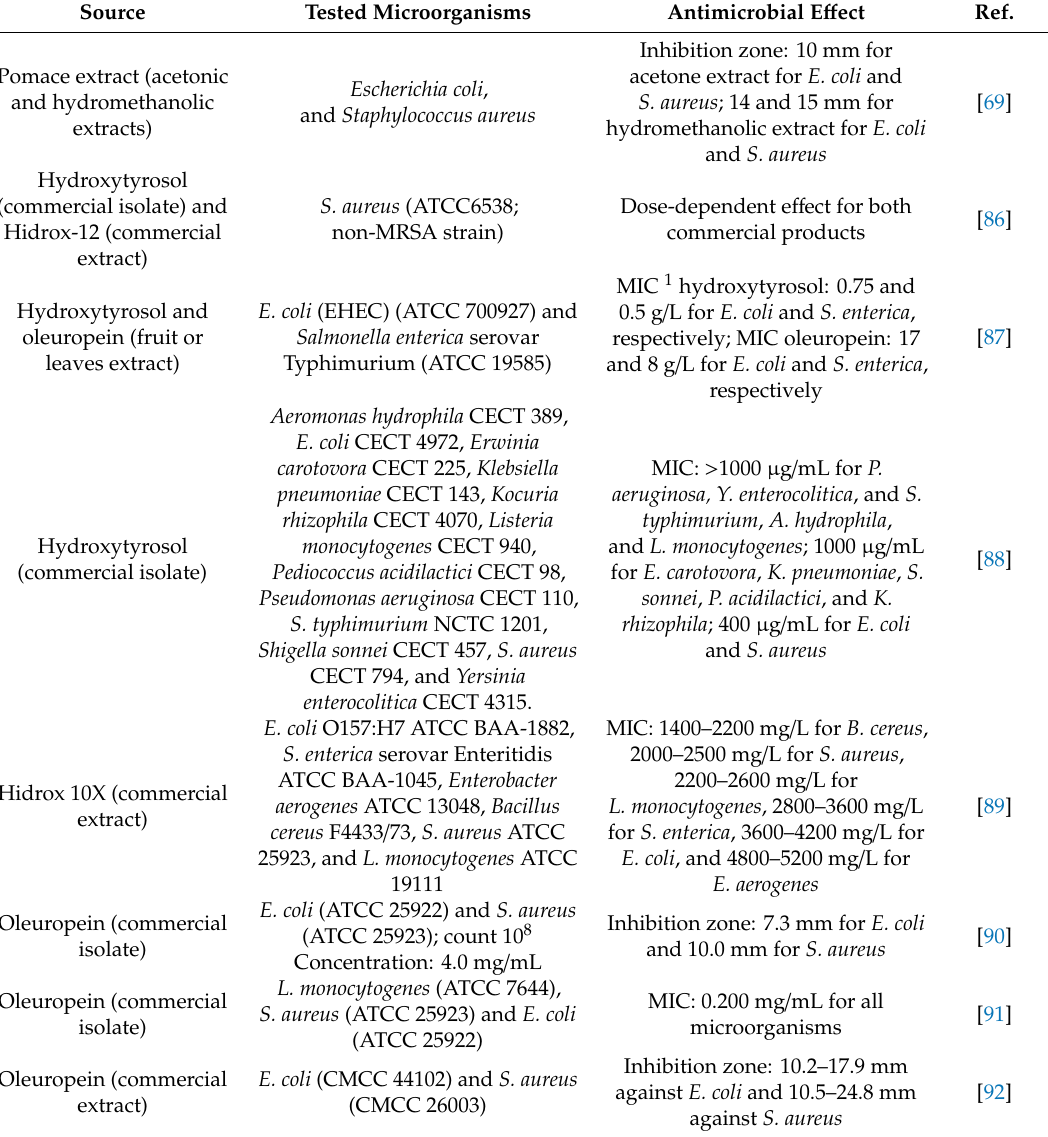
Table 4. Antimicrobial activity in vitro of polyphenol-rich extracts and isolated compounds from Olea europaea